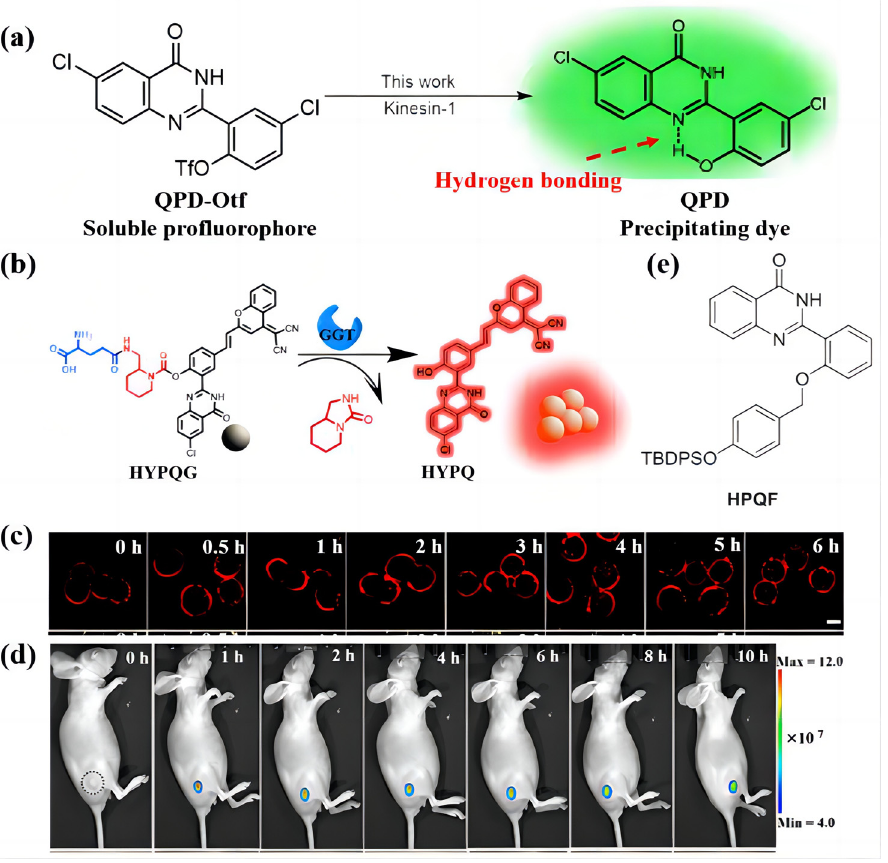
Figure 6. ( a ) The molecular structure of QPD ‐ Otf and QPD. ( b ) The chemical structure and photophysical properties of HYPQG. Adapted with permission from [75]. ( c ) The long ‐ term in situ images of HYPQG. Adapted with permission from [75]. ( d ) The long ‐ term in situ imaging of GGT in mouse tumors. In vivo real ‐ time imaging of GGT in A2780 ‐ bearing nude mice after tumor injection of 20 μ M HYPQG. Adapted with permission from [75]. ( e ) The molecular structure of HPQF.